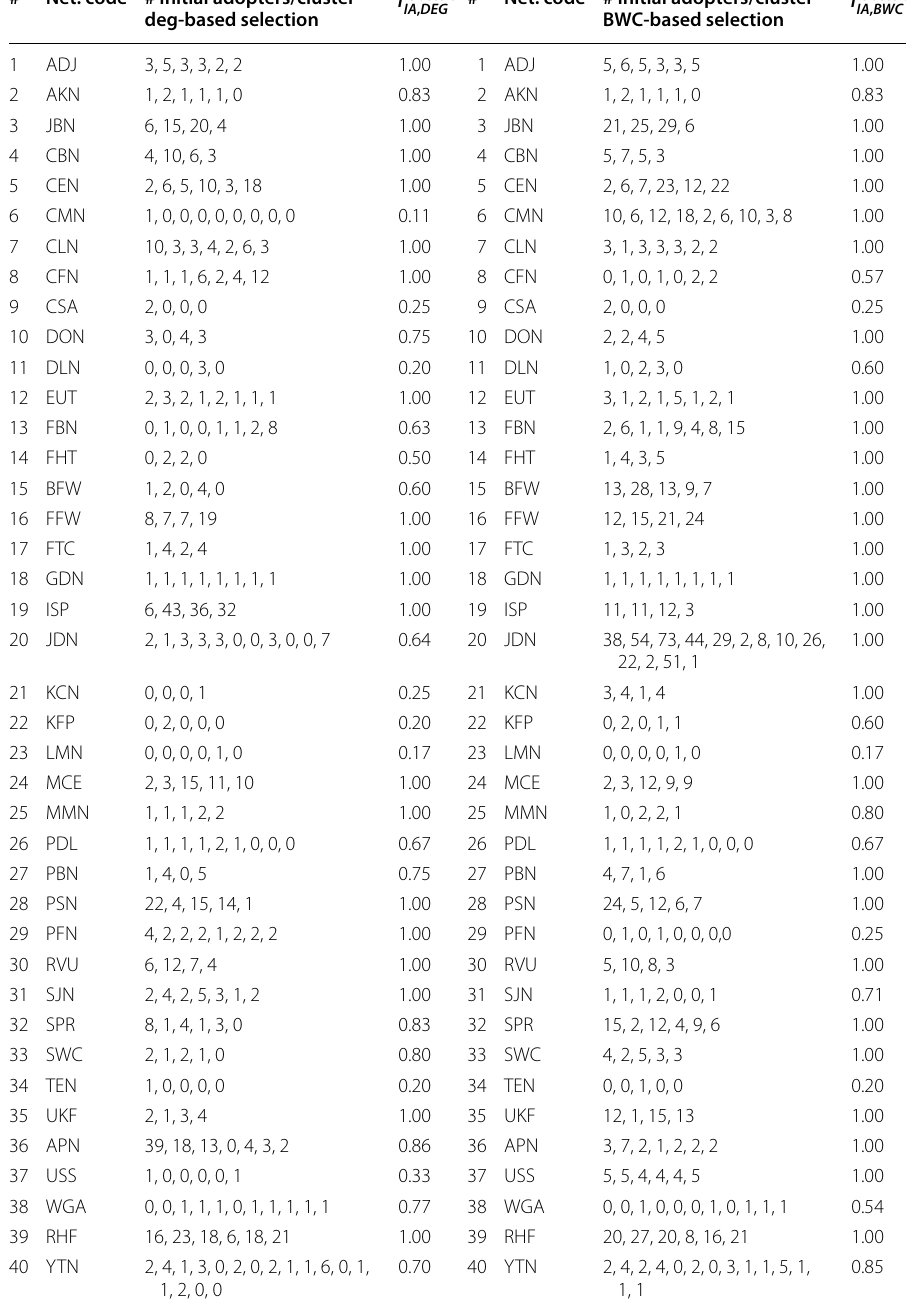
Table 5 Distribution of the initial adopter nodes (chosen based on the DEG and BWC centrality metrics) in the Louvain clusters of the real‑world networks f Clusters # Net. code # Initial adopters/cluster # Net. code # Initial adopters/cluster IA , DEG deg‑based selection BWC‑based